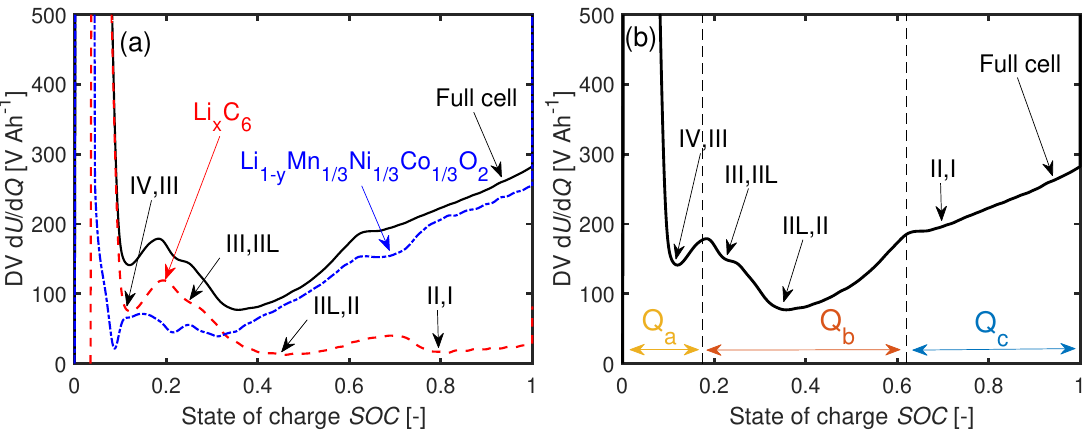
Figure 1. ( a ) Differential voltages d U /d Q of the full cell and the electrode potentials of a coin cell at BOL. The phase transitions between the GR stages are visible in the full cell differential voltage (DV). ( b ) Phase widths Q a , Q b , and Q c assigned to the full cell DV.